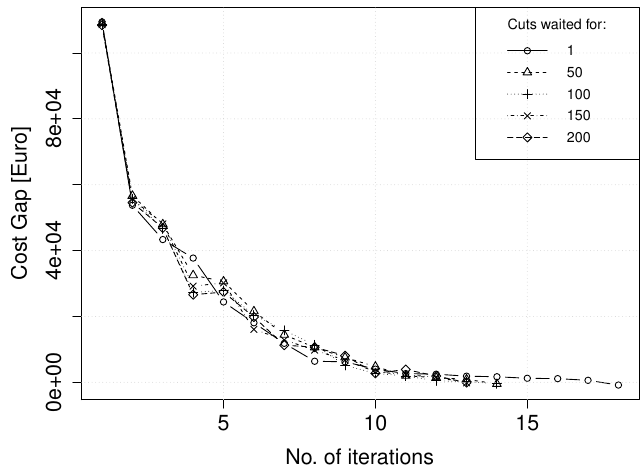
Figure 7. Cost gap as a function of the number of iterations in the SDDP algorithm. The data are from Case 2, with N P = 144 and with different values of N W